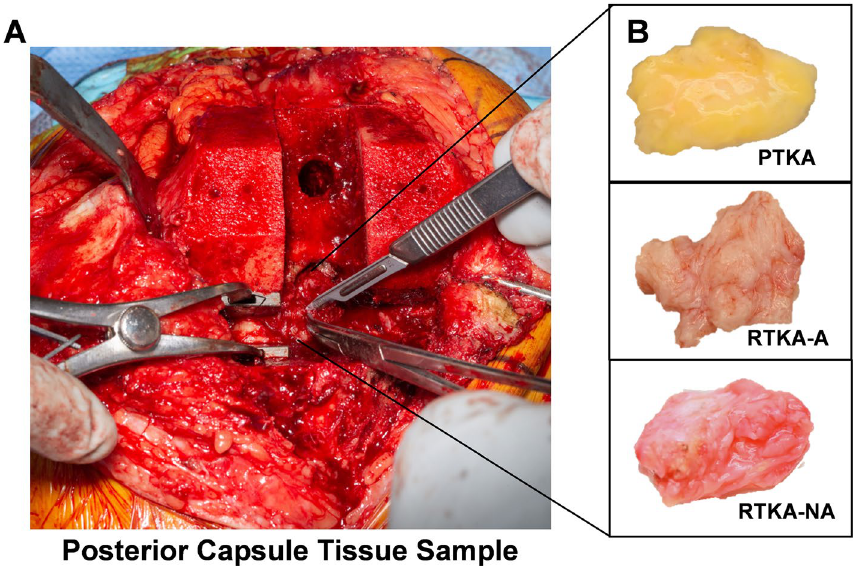
Figure 1. Intraoperative harvesting of posterior capsule tissue samples. An intraoperative photograph of the posterior capsule tissue sampling site ( A ). Gross appearance of representative posterior capsule specimens from each of the three patient groups ( B ). Abbreviations: TKA = total knee arthroplasty, PTKA = primary TKA, RTKA-A = revision TKA for arthrofibrosis, RTKA-NA = revision TKA for non-arthrofibrotic conditions.